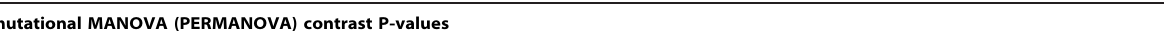
Permutational MANOVA (PERMANOVA) contrast P-values Sample vs.